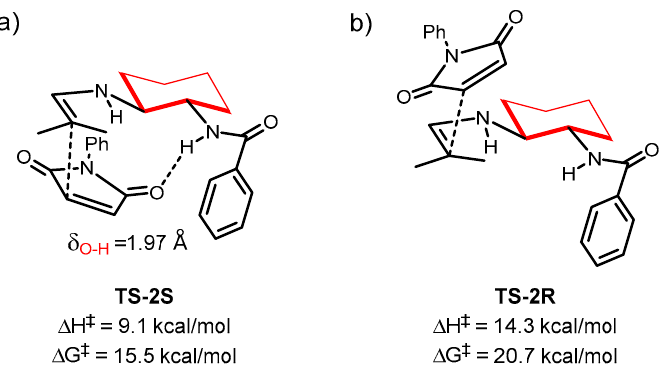
Figure 5. Transition states for the formation of ( S )- 18aa ( a ) and ( R )- 18aa ( b ) catalyzed by 19 .